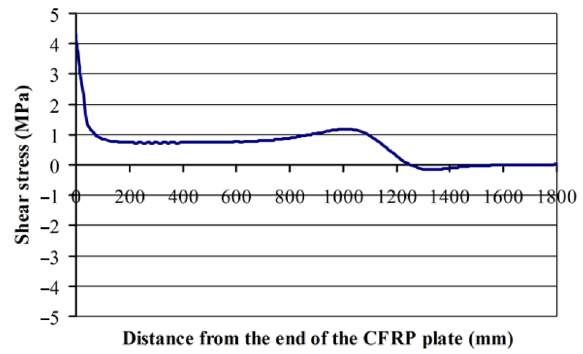
Fig. 13. Shear stress distribution in adhesive layer at ultimate load for Series B